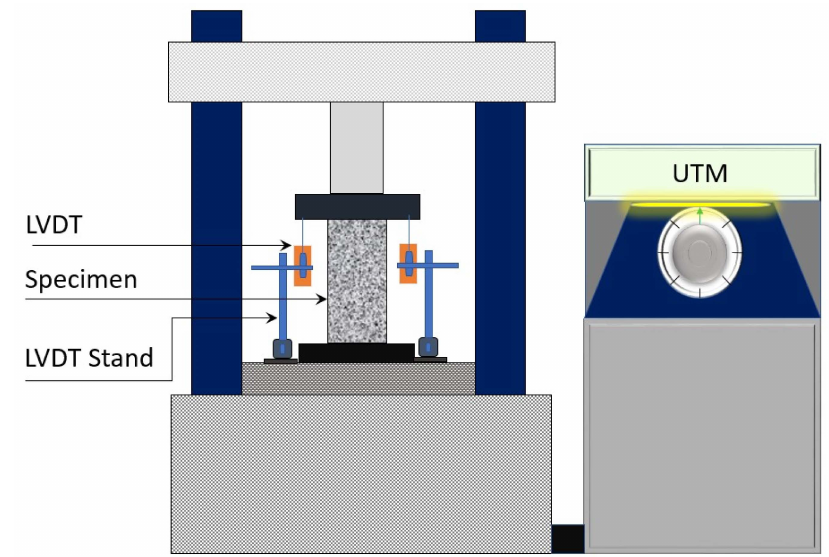
Figure 5. Typical test